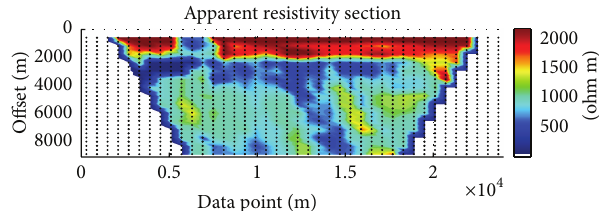
Figure 16: 2D apparent resistivity section for South China shale gas